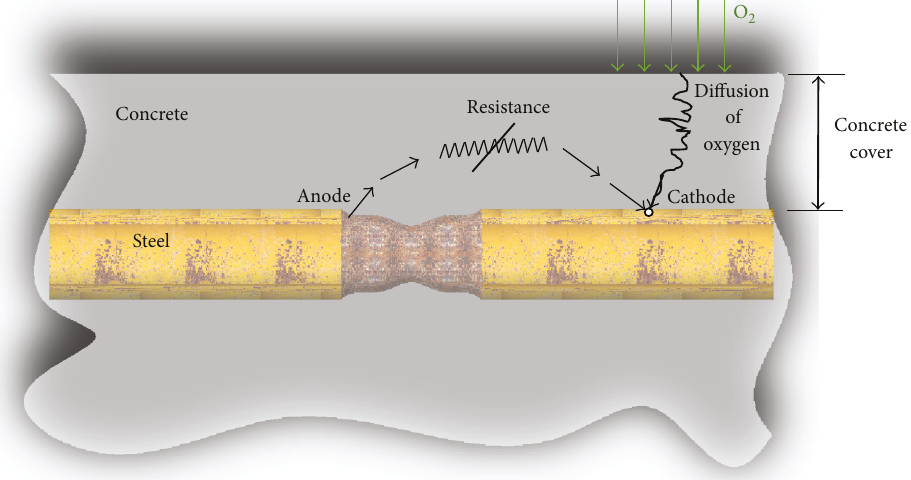
Figure 11: Schematic descriptions of factors which may affect corrosion rate of steel in concrete: (i) O 2 availability and (ii) electrical resistance of concrete (reproduced from